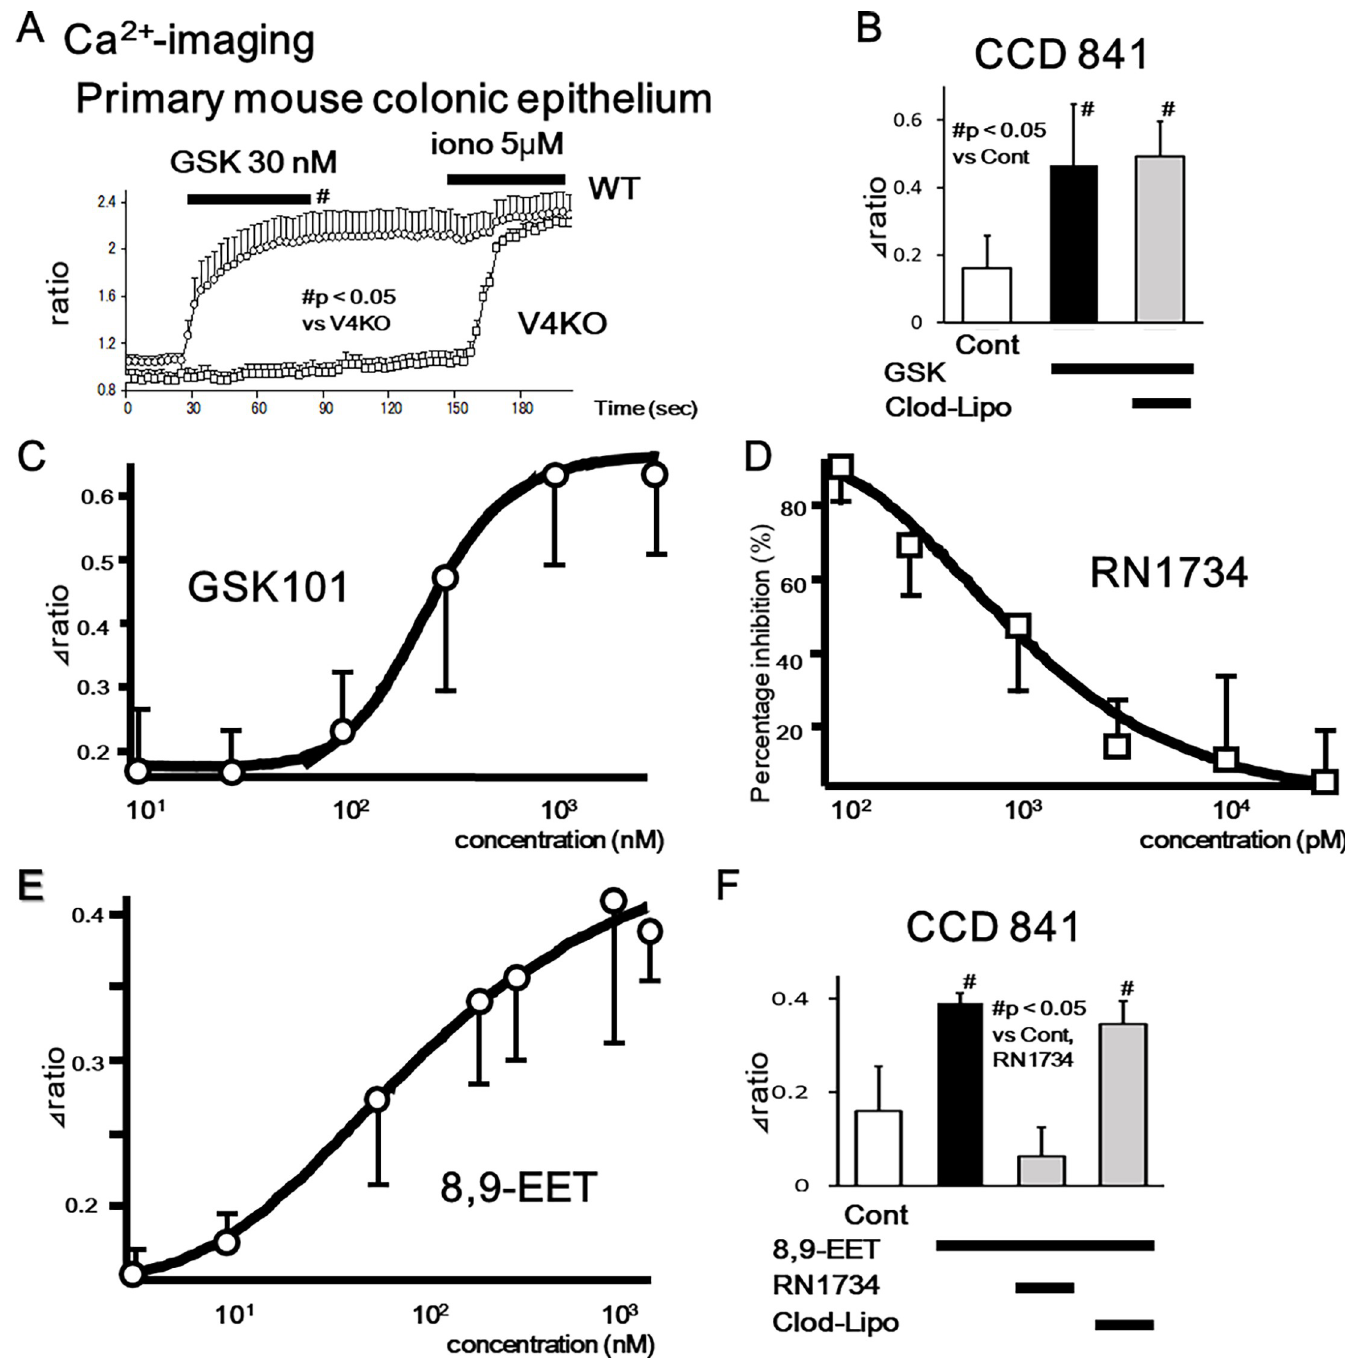
Fig 3. TRPV4-mediated increase in cytosolic Ca 2+ ([Ca 2+ ] i ) in mouse primary colonic epithelial cells and CCD 841 cells. (A) [Ca 2+ ] i changes in response to the TRPV4 specific agonist, GSK101 (GSK, 30 nM), in WT or TRPV4-KO (V4KO) primary colonic epithelial cells (mean ± SEM). Ionomycin (iono) was used as a positive control. Bars indicate the period of chemical application. Significant increases in [Ca 2+ ] i at 90 seconds were observed in WT than V4KO (p < 0.05). (B) GSK101 (300 nM) significantly increased [Ca 2+ ] i in CCD 841 cells (mean ± SEM, n = 17) compared to basal conditions (# p < 0.05 vs control). Clodronate-liposomes did not affect the [Ca 2+ ] i responses. (C) Dose-response [Ca 2+ ] i increase curve in CCD 841 cells responding to GSK101 determined EC50 value of 231.3 nM. (D) Dose-response [Ca 2+ ] i inhibition curve with a TRPV4 specific inhibitor, RN1734 in CCD 841 cells responding to GSK101 (3 μ M) determined IC50 value of 702.6 pM. (E) Dose-response [Ca 2 + ] i increase curve in CCD 841 cells responding to an endogenous TRPV4 agonist, 8,9-EET determined EC50 value of 111.1 nM. (F) 8,9-EET (1.5 μ M) significantly increased [Ca 2+ ] i in CCD 841 cells (mean ± SEM, n = 11) compared to basal conditions (# p < 0.05 vs control). RN1734 (10 μ M) significantly inhibited the [Ca 2+ ] i responses, but clodronate-liposomes did not.